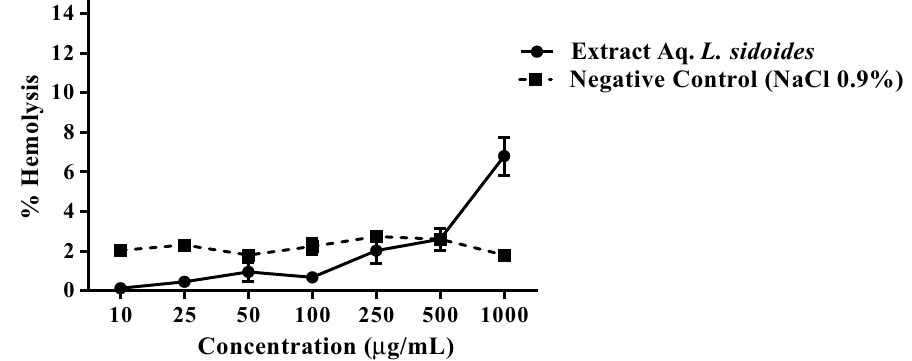
Figure 4. hemolytic effect on blood cells treated with aqueous extract of L. sidoides . The percentage of hemolysis was plotted for each concentration against the control with 100% hemolysis (NaCl 0.12%).